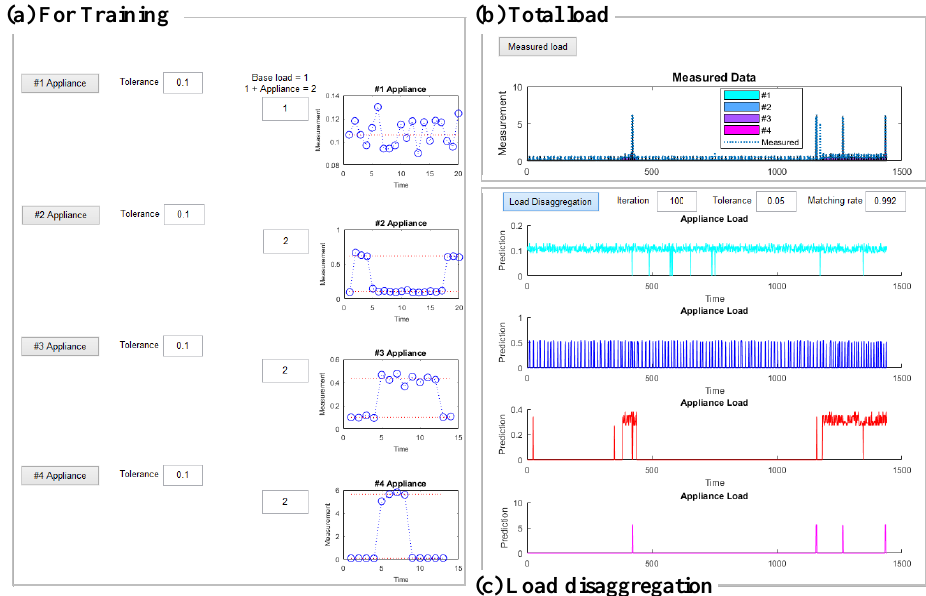
Figure 7. Configuration and implementation example of the load disaggregation algorithm platform using MATLAB GUI [26].